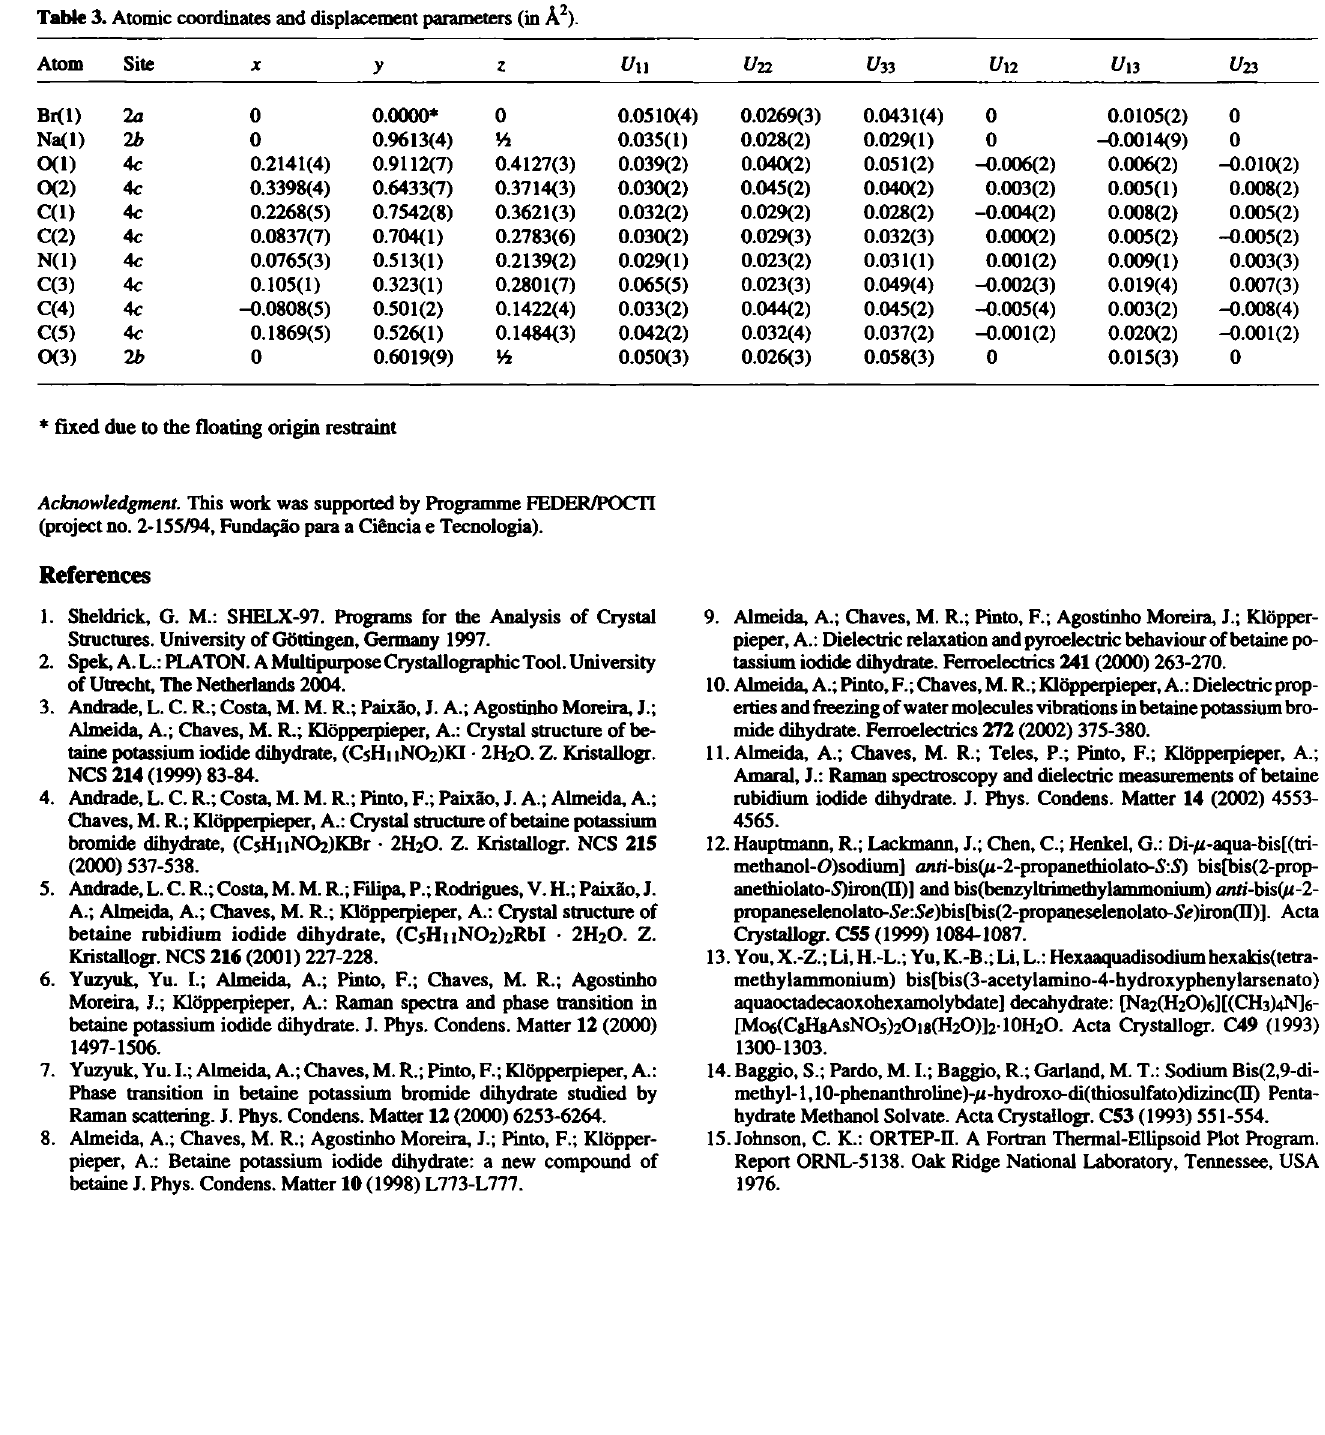
Table 3. Atomic coordinates and displacement parameters (in Ä 2